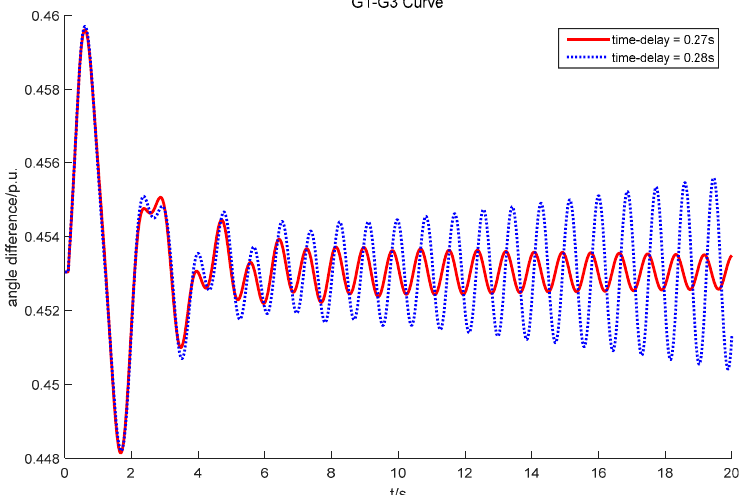
Figure 13. G1–G3 power angle difference curves with time-delays near the threshold.